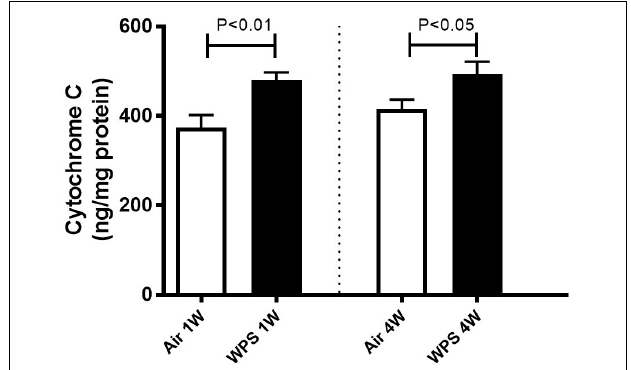
FIGURE 9 | Kidney homogenate concentrations of cytochrome C in mice at the end of the 1-week and 4-week exposure periods to air (control) or water-pipe smoke (WPS). Data are mean ± SEM ( n =